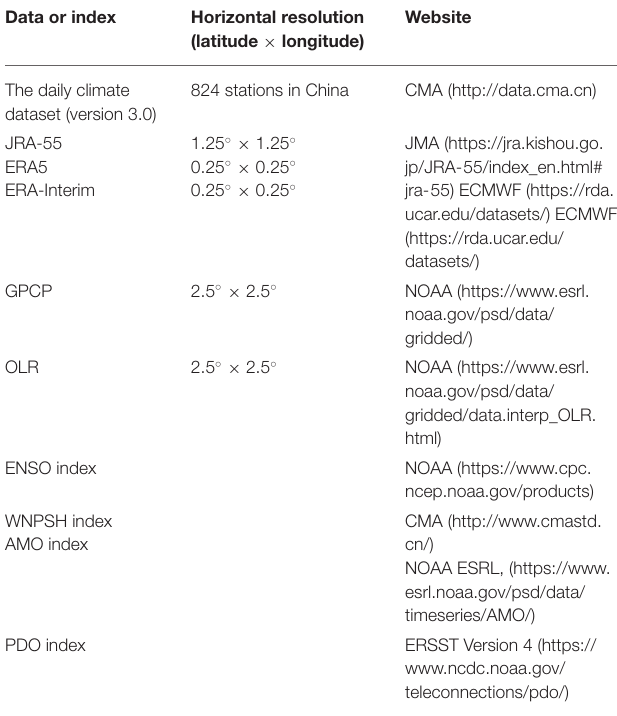
TABLE 1 | The various datasets and indexes used in this study and the corresponding